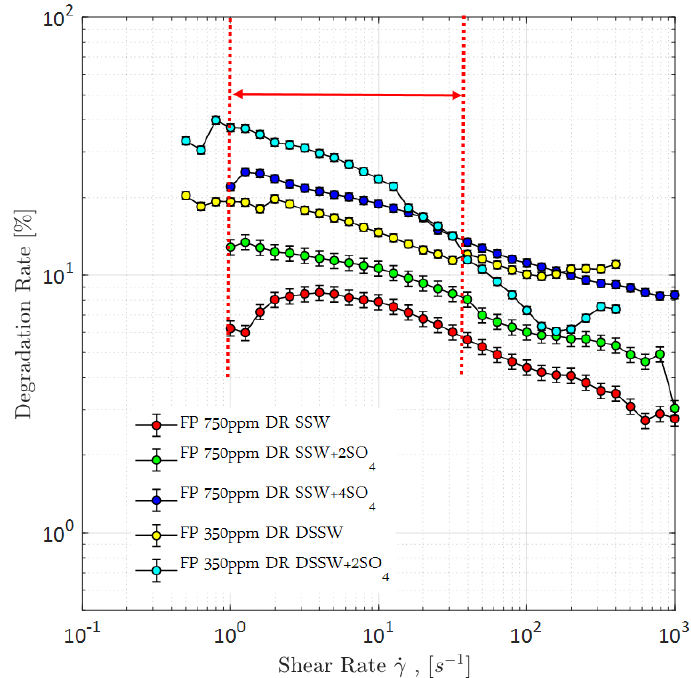
Figure 20. Degradation rate of Flopaam (FP) polymer solutions. Vertical red-lines represent the range of in-site shear rate in reservoir. DR SSW represents the degradation rate of polymer solutions prepared in synthetic seawater at 350 ppm and 750 ppm concentrations. Similarly DR SSW + 2SO 4 denotes degradation rate of polymer solutions prepared in synthetic seawater with doubled amount of sulfate and DR SSW + 4SO 4 denotes degradation rate of polymer solutions prepared in synthetic seawater with quadruple amount of sulfate.